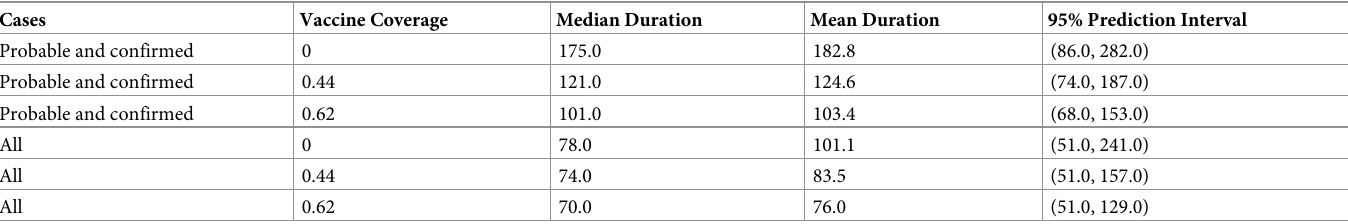
Table 2. Distribution of projected outbreak duration from stochastic branching process model. Mean, median and 95% prediction interval of outbreak duration, by proportion of vaccine coverage, using probable and confirmed cases with and without suspected cases.